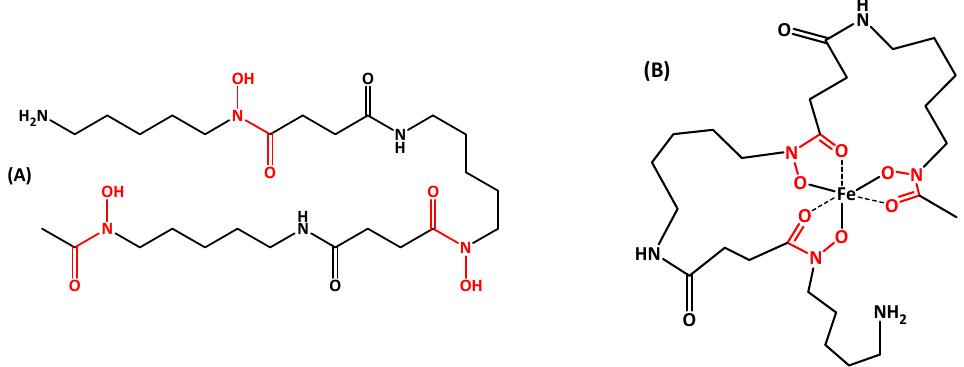
Scheme 1. Chemical structure of ( A ) deferoxamine B (DFOB) and ( B ) feroxamine B (FOB). Hy- droxamic groups, responsible for metal chelation, are evidenced in red.